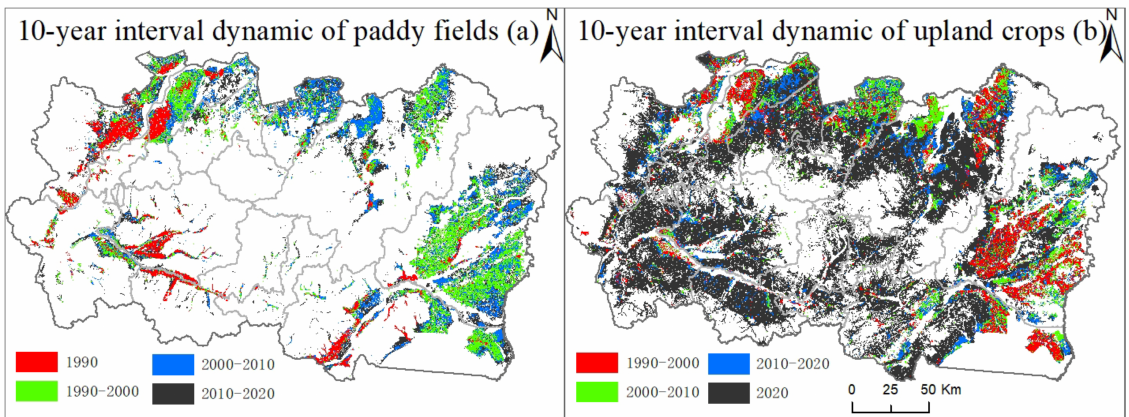
Figure 4. Spatial pattern of cropland structure from 1990 to 2020. Note: ( a ) and ( b ) were the 10-year interval dynamic of paddy fields and upland crops, respectively.